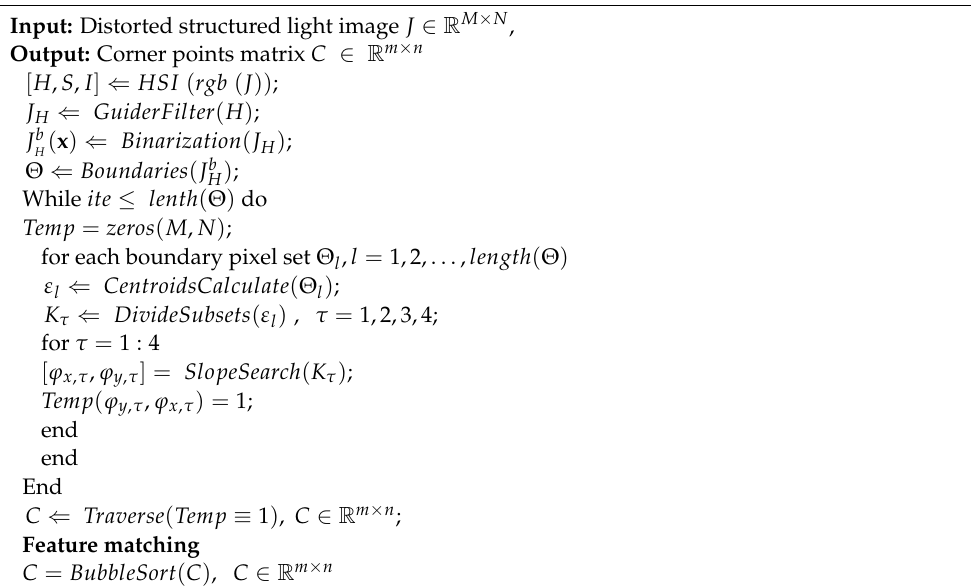
Algorithm 1 : A Slope Search-based Corner Detection